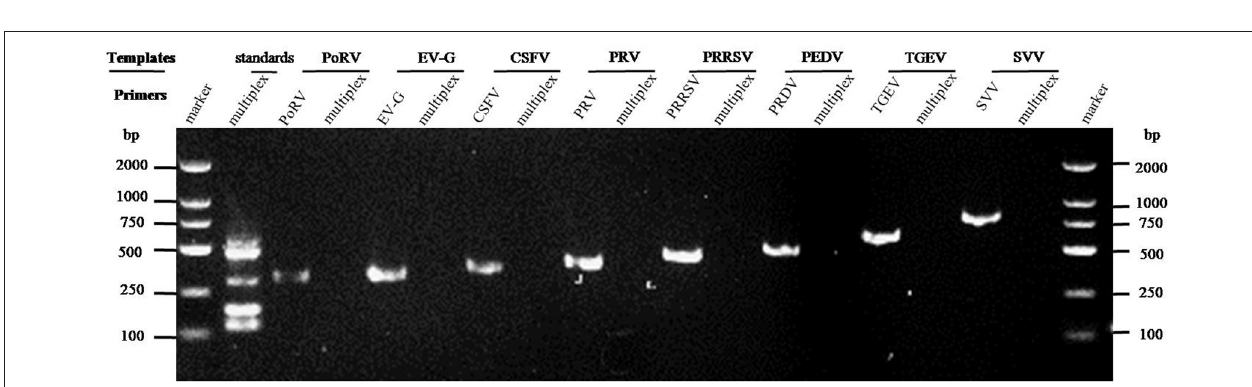
FIGURE 4 | Specificity analysis of the multiplex RT-PCR method established in this study. The cDNA or DNA obtained from common swine viruses circulating in Chinese pig herds was used as templates to validate the specificity of the multiplex RT-PCR assay. The porcine astrovirus (PAstV) standards were mixed and used as positive control. Primers specific to other individual viruses were employed as internal controls. Primer sequences are shown in Table 2